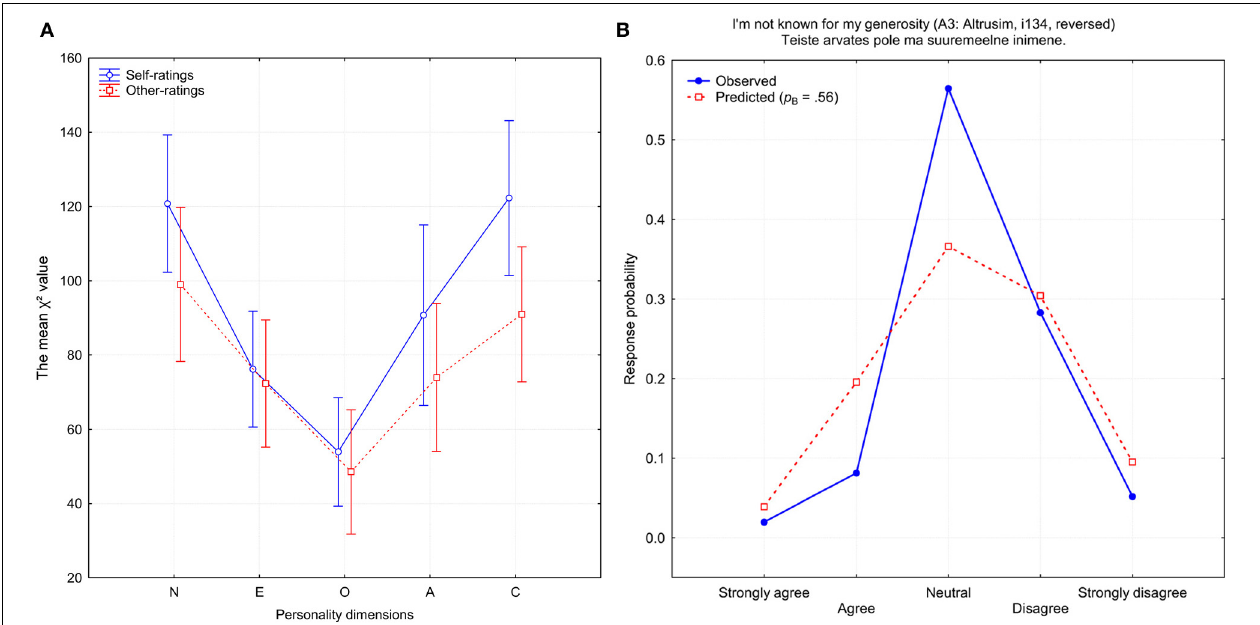
FIGURE 6 | (A) The mean χ 2 approximation error for items belonging to one of the five personality dimensions: N, Neuroticism; E, Extraversion; O, Openness, A, Agreeableness, and C, Conscientiousness. (B) Observed (blue) and predicted (red) response probabilities for the self-rated item i 134 (A3: Altruism).